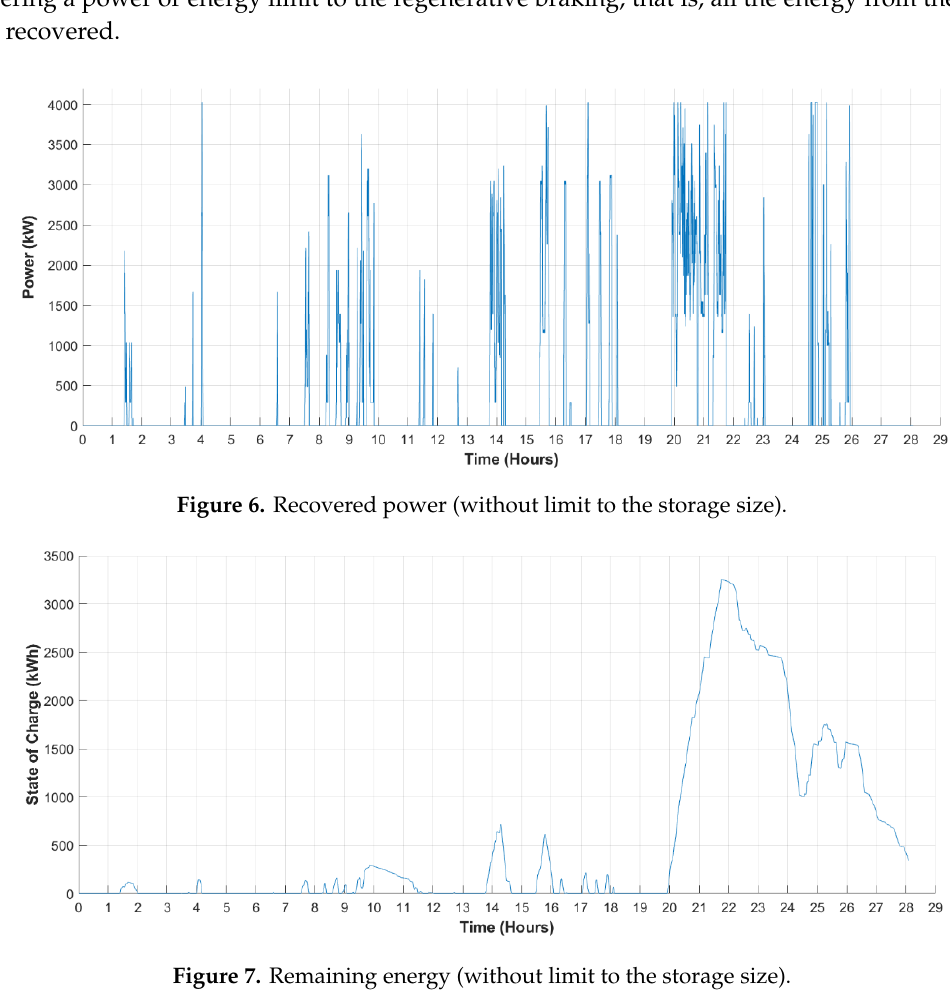
Figure 5. Demand profile with and without energy recovery (part of the trip).